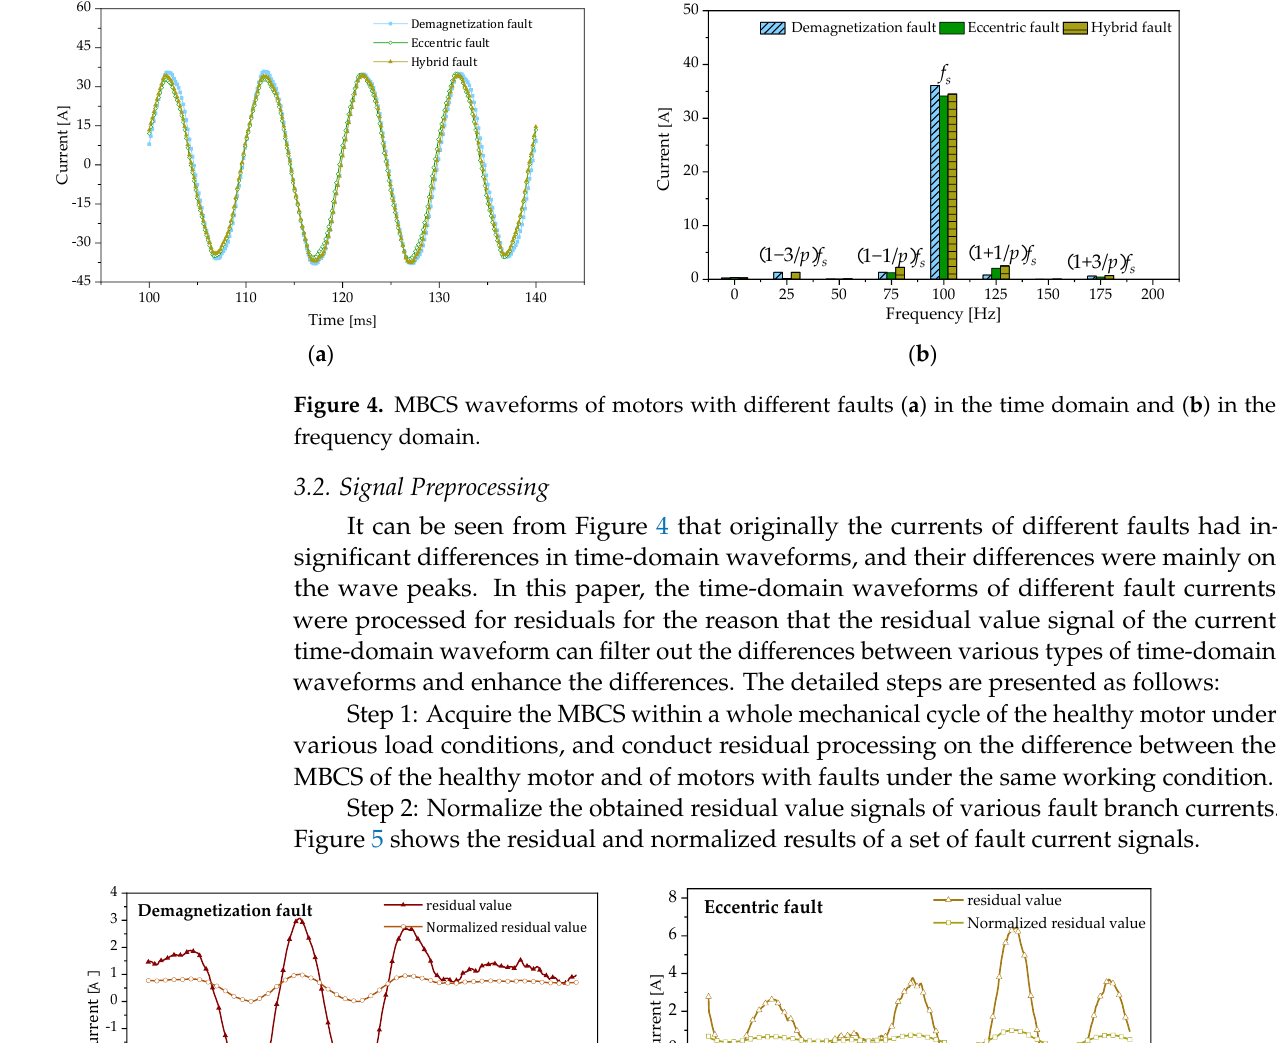
Figure 4. MBCS waveforms of motors with different faults ( a ) in the time domain and ( b ) in the frequency domain.